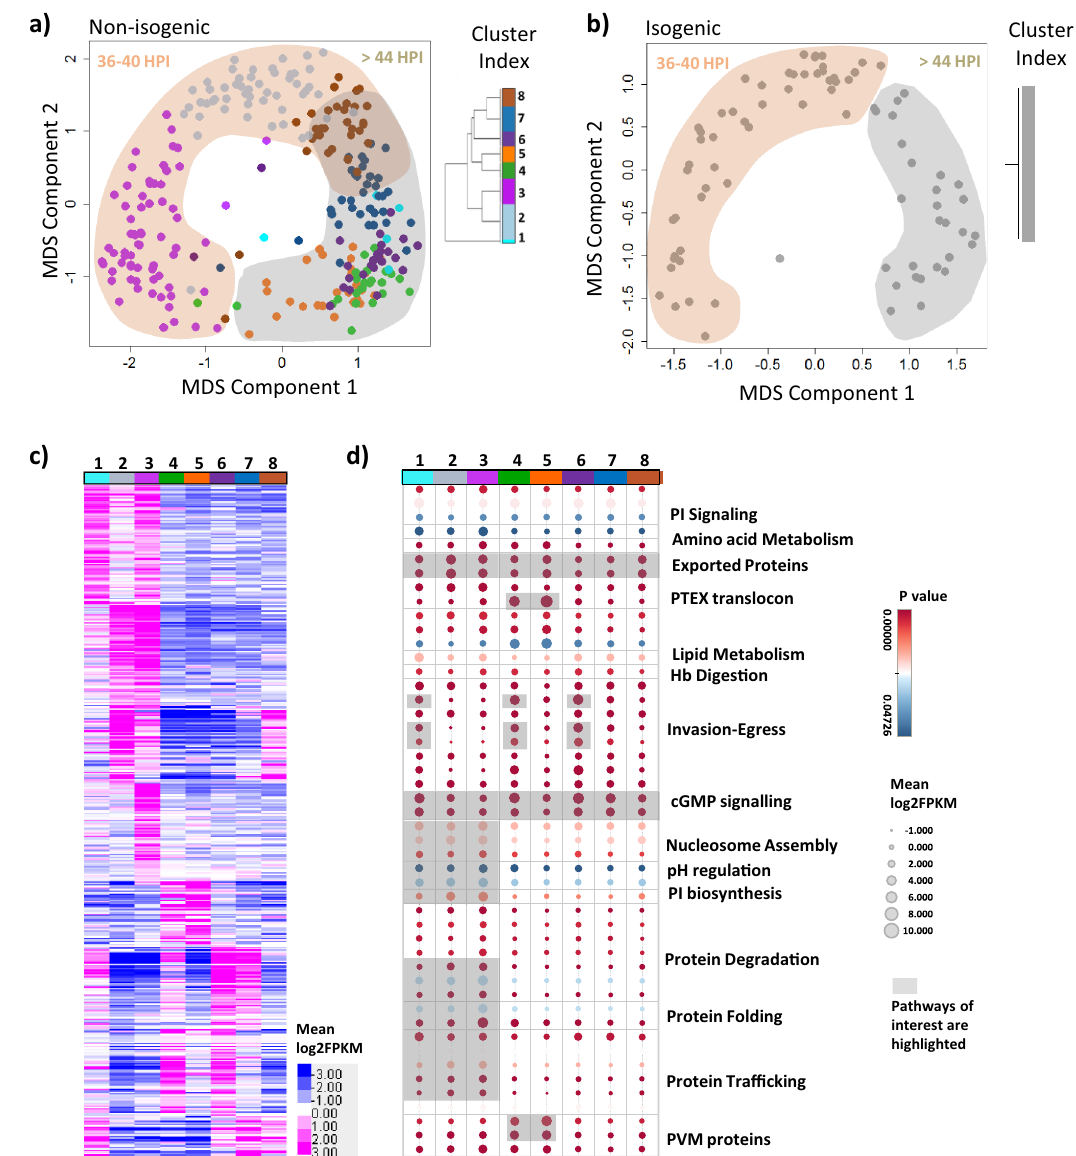
Fig. 2 Schizont subpopulations with unique transcriptional pro fi les identi fi ed in non-isogenic P. falciparum parasites. A multidimensional scaling (MDS) plot showing fi rst two components (MDS1 and MDS2) depicting maximum differences between individual schizonts in a non-isogenic and b isogenic group. RSEC-based SCTS hierarchy is shown in right hand inset (for both ( a , b )) with each SCTS represented by a different colour for non-isogenic schizonts. The two major age groups (36-40 HPI and >44 HPI) identi fi ed has been overlaid on the MDS plot. c A heatmap showing average expression of differentially expressed (DE) genes (mean normalised log2FPKM) in each SCTS of non-isogenic parasites. d A dot plot of various functional pathways enriched in non-isogenic parasite SCTS. The colour and size of each circle depicts p -value and mean log2FPKM value respectively with pathways of interest highlighted in grey. Source data are provided as a Source Data fi